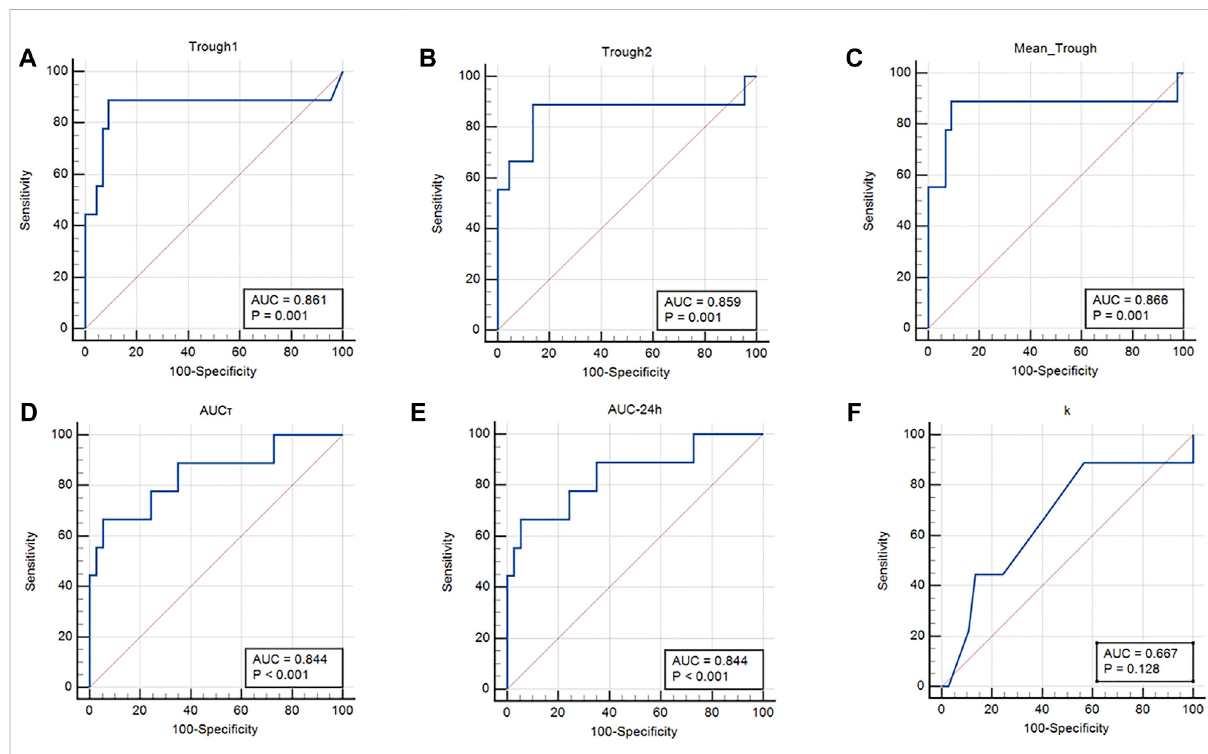
FIGURE 3 Area under the ROC curves. (A) Trough concentration 1 (0 h); (B) Trough concentration 2 (12 h); (C) Mean trough concentration; (D) AUC τ , (E) AUC 24h ; and (F) Elimination constant